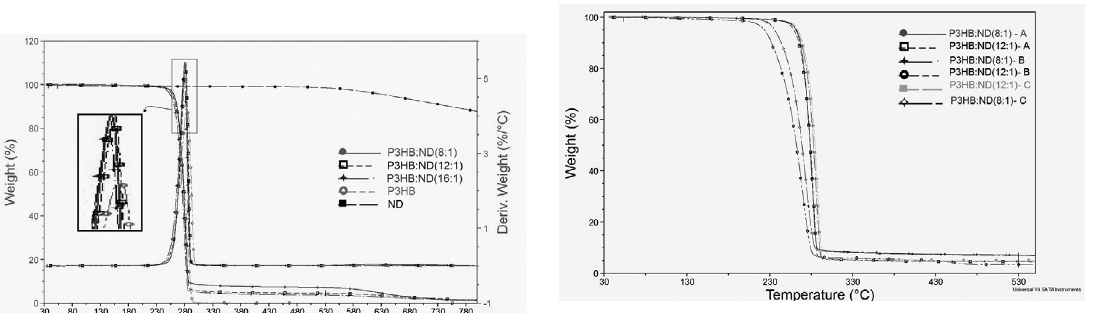
Figure 2: TGA curve from samples taken from different regions of P(3HB):ND(8:1) and (12:1) specimen. Table 2: Melting enthalpy, crystallinity and melting temperature, obtained by DSC for raw P(3HB) and the three composite